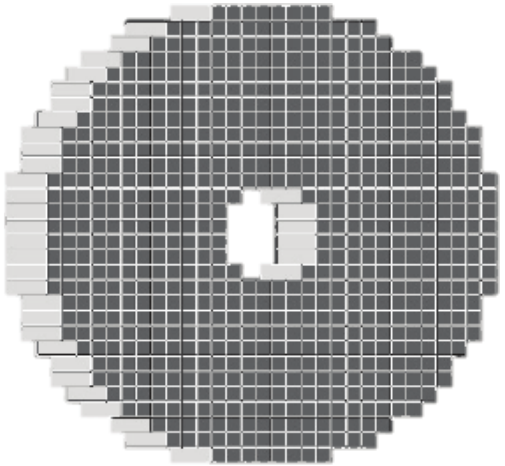
Figure 13: Missing mass resolution as a function of the 𝑈 boson mass for four different energies of the impinging positron